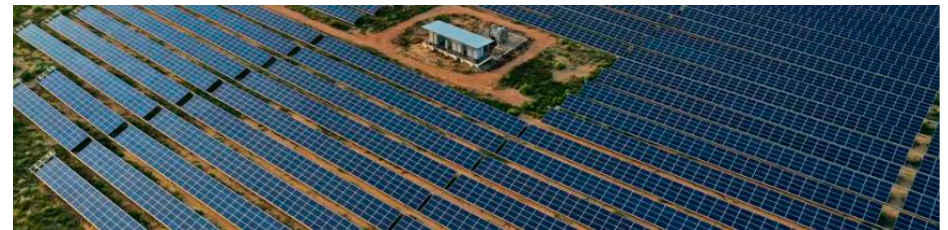
Figure 10. Bhadla solar park in India [20].